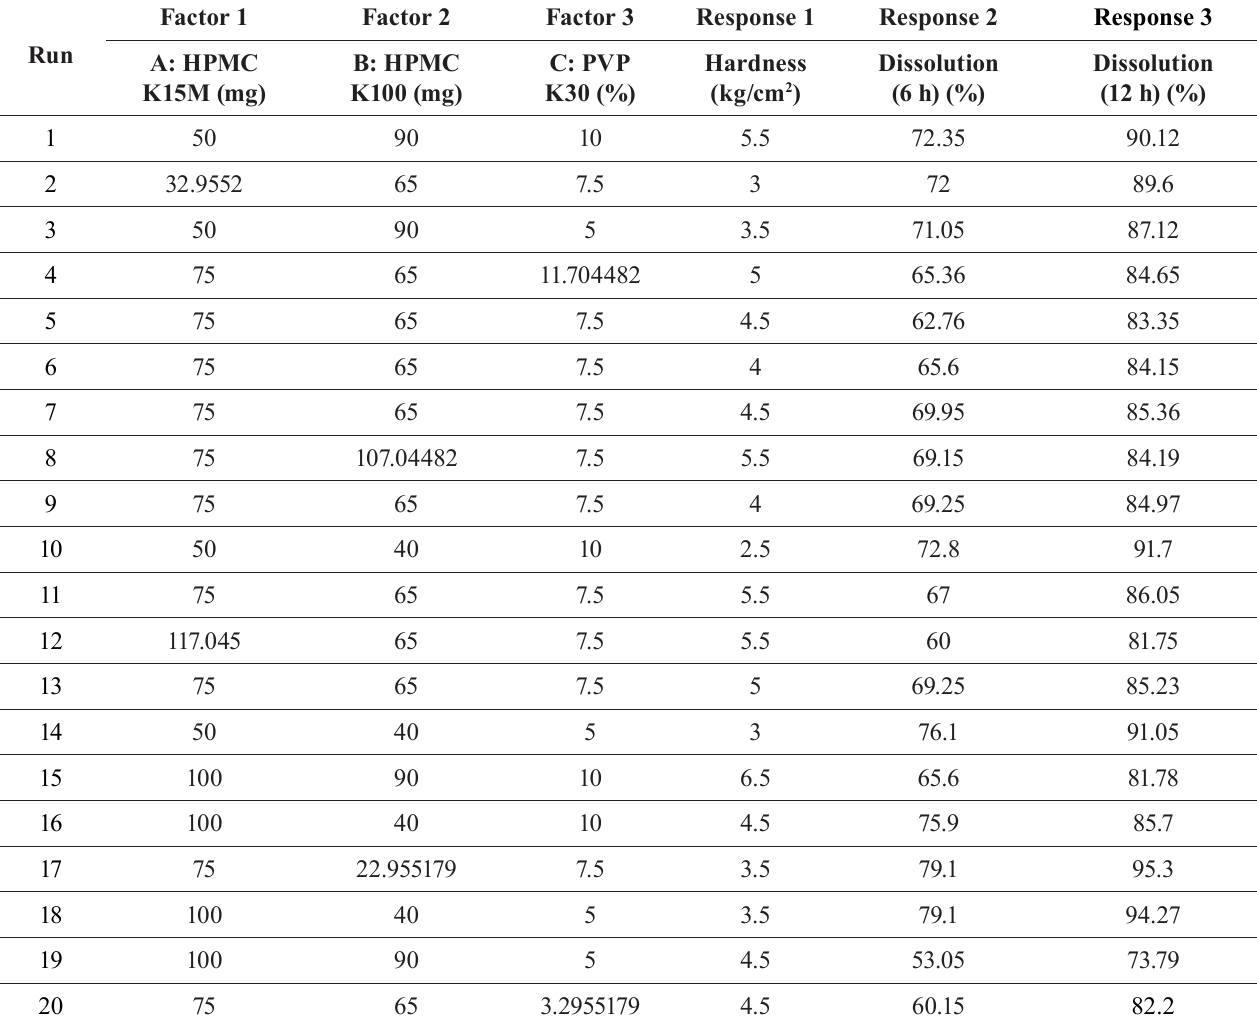
TABLE III - Batches suggested by central composite design for optimization study